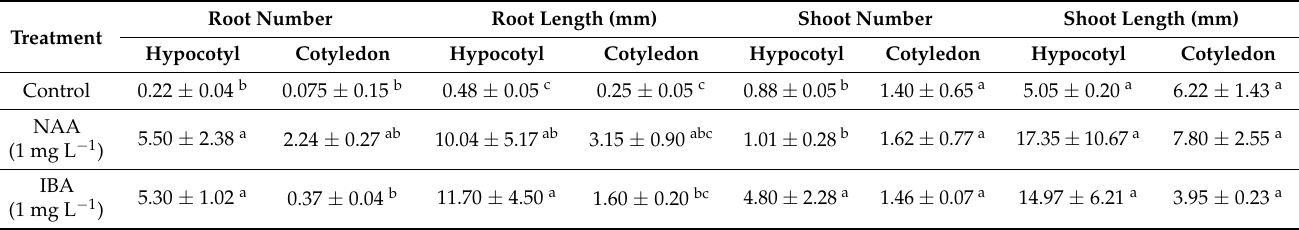
Table 2. Comparison of the effects of NAA and IBA on rooting parameters and shoot traits of Artemisia spicigera .